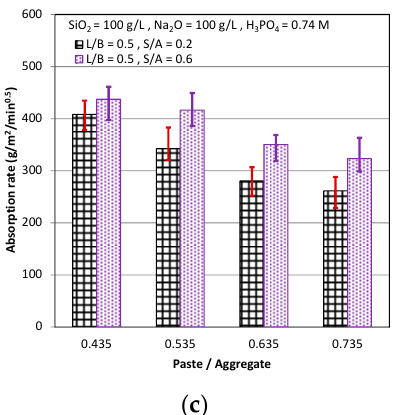
Figure 4. Absorption rate: ( a ) P/A = 0.635, L/B = 0.5; ( b ) P/A = 0.635, S/A = 0.2 & 0.6; and ( c ) L/B = 0.5, S/A = 0.2 & 0.6.